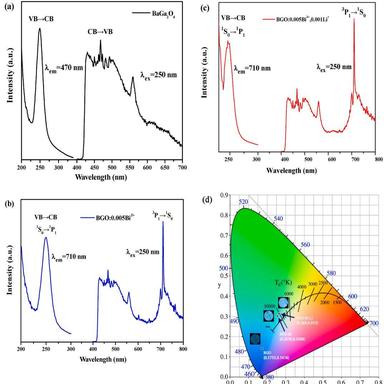
PLE and PL spectra of (a) BGO host, (b) BGO: 0.005Bi3+ and (c) BGO: 0.005Bi3+, 0.001Li+. (d) is CIE chromaticity diagram of three typical samples.